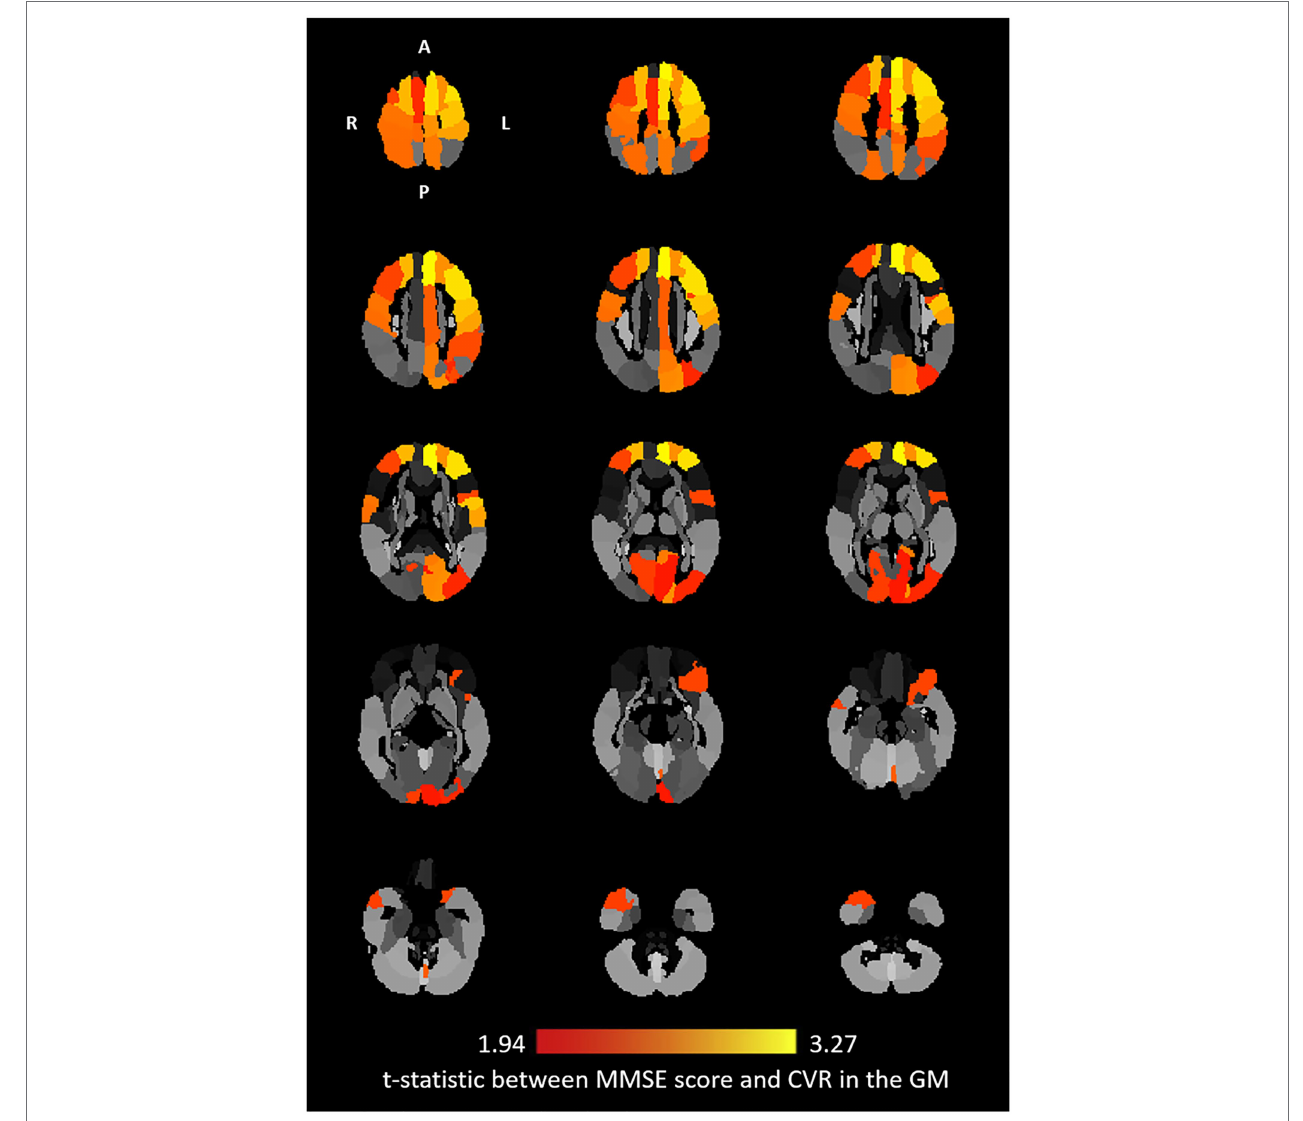
FIGURE 3 | Covariates adjusted t-statistic: axial view of the relationship between CVR and MMSE score at the regional level in the gray matter. Twenty-six ROIs were reported from the multivariate linear regression where corrected value of p < 0.05 [Automated Anatomical Labeling (AAL) ROIs: Left Precentral, Right Precentral, Left Superior Frontal, Right Superior Frontal, Left Middle Frontal, Right Middle Frontal, Left Inferior Frontal Operculum, Left Inferior Frontal Orbital, Left Superior Motor, Right Superior Motor, Left Superior Medial Frontal, Left Middle Cingulum, Left Calcarine, Right Calcarine, Left Cuneus, Left Superior Occipital, Left Middle Occipital, Left Postcentral, Right Postcentral, Right Superior Parietal, Left Inferior Parietal, Left Precuneus, Left Central Paracentral Lobule, Right Central Paracentral Lobule, Right Middle Temporal Pole, and Left Vermis 6]. The brightest yellow color corresponds to a maximum t-statistic among the